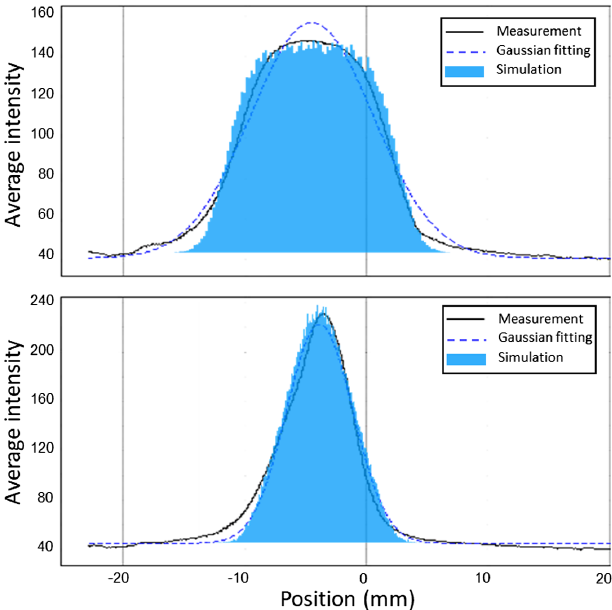
FIG. 5. Density distribution of the electron beam on a YAG screen and simulation result. Top: With no ion beam in the yellow ring. Bottom: With an ion beam in the yellow ring.